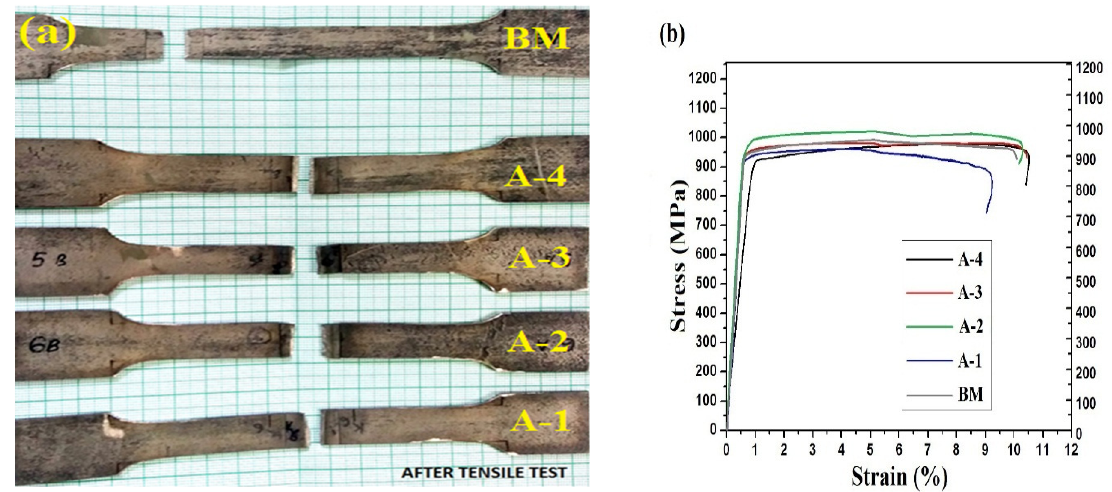
Figure 8. ( a ) Tensile tested samples of the Ti-6Al-4V; ( b ) Stress–strain curve of the Ti-6Al-4V.